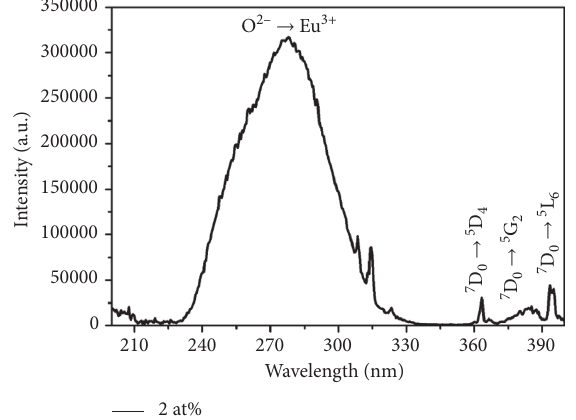
3+ Figure 6: The CIE coordinate diagram of the SrGd 2 O 4 :Eu